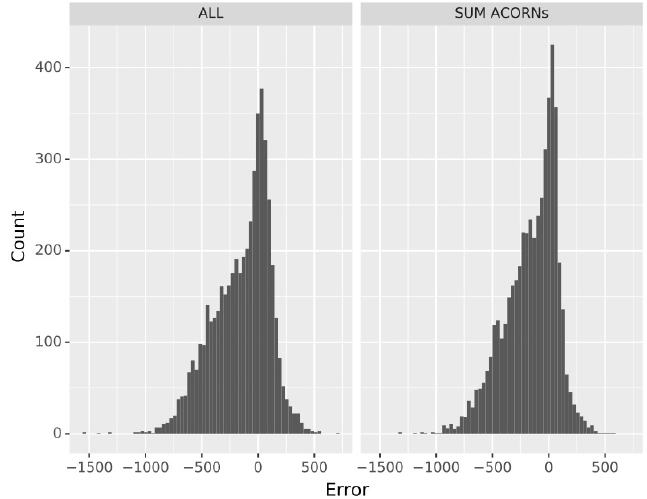
Figure 4. Histogram of the residuals for all customers (ALL, left) and the sum of the residuals of each ACORN individually (right).